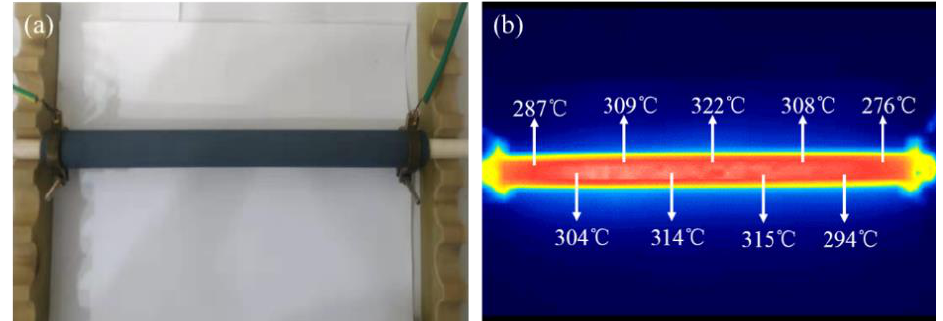
Figure 6. Photograph of electrical-heating coating sample ( a ) and infrared thermal image of coating during the holding stage ( b ).